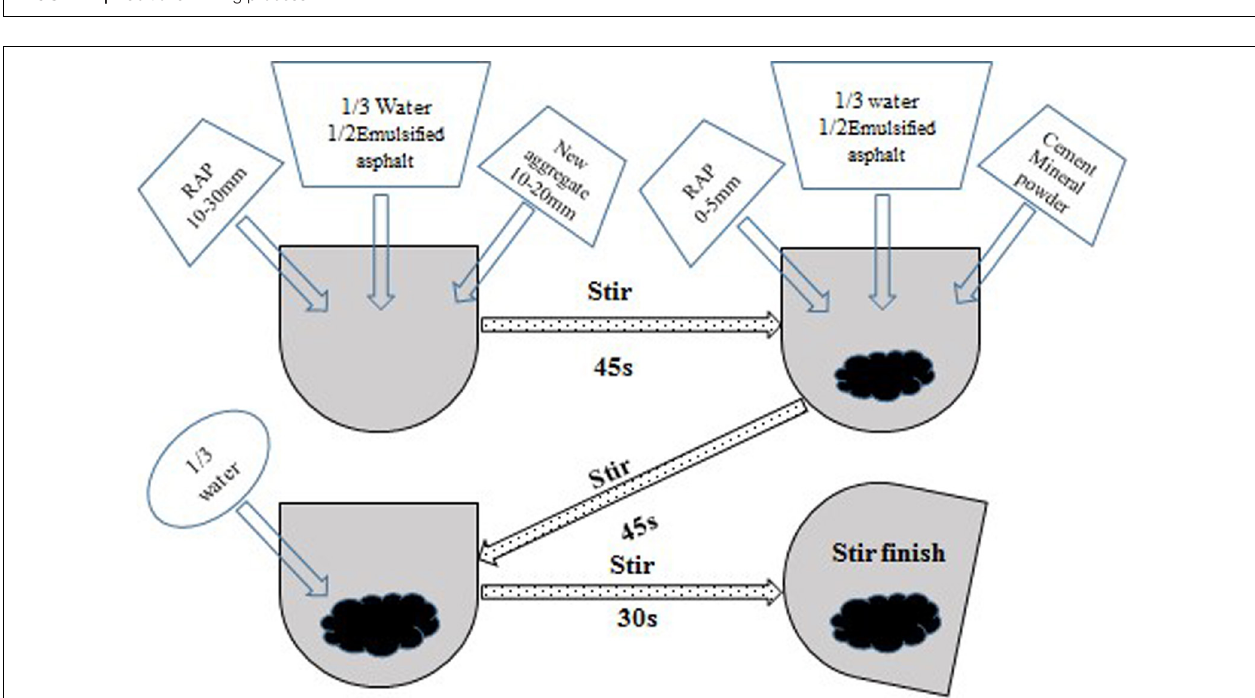
FIGURE 3 | New mixing